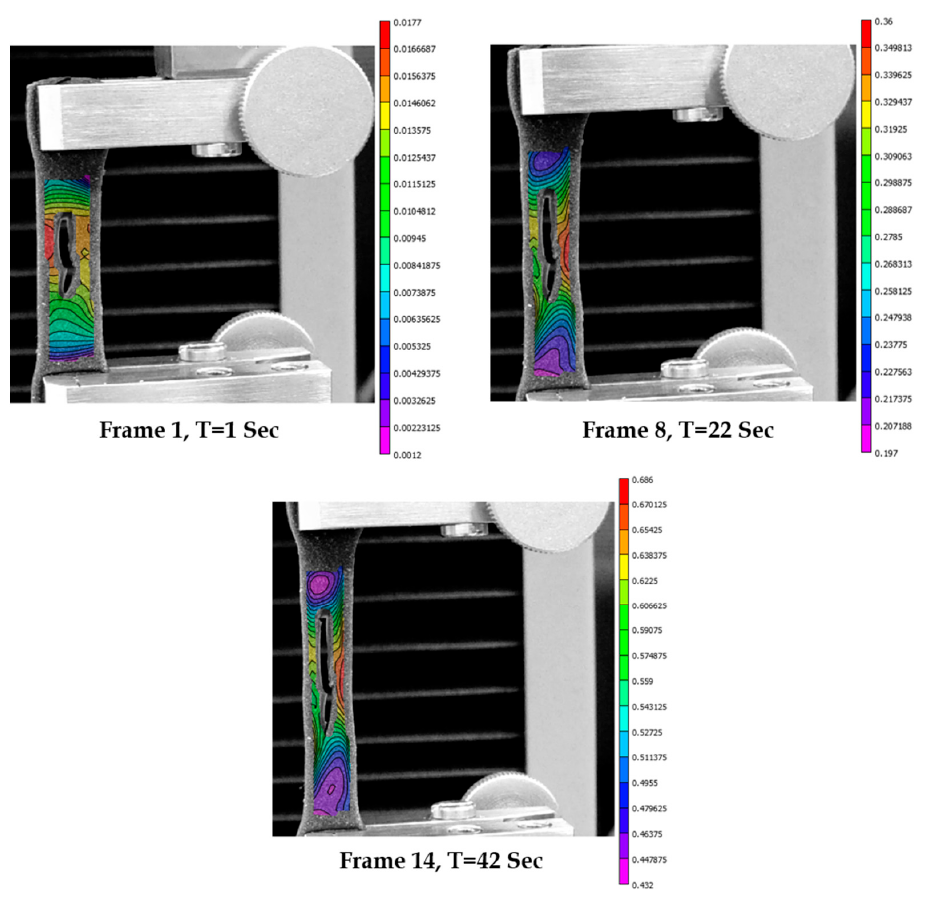
Figure 12. Strain distribution at different times for asymmetric long wound 3 measured using DIC technique.